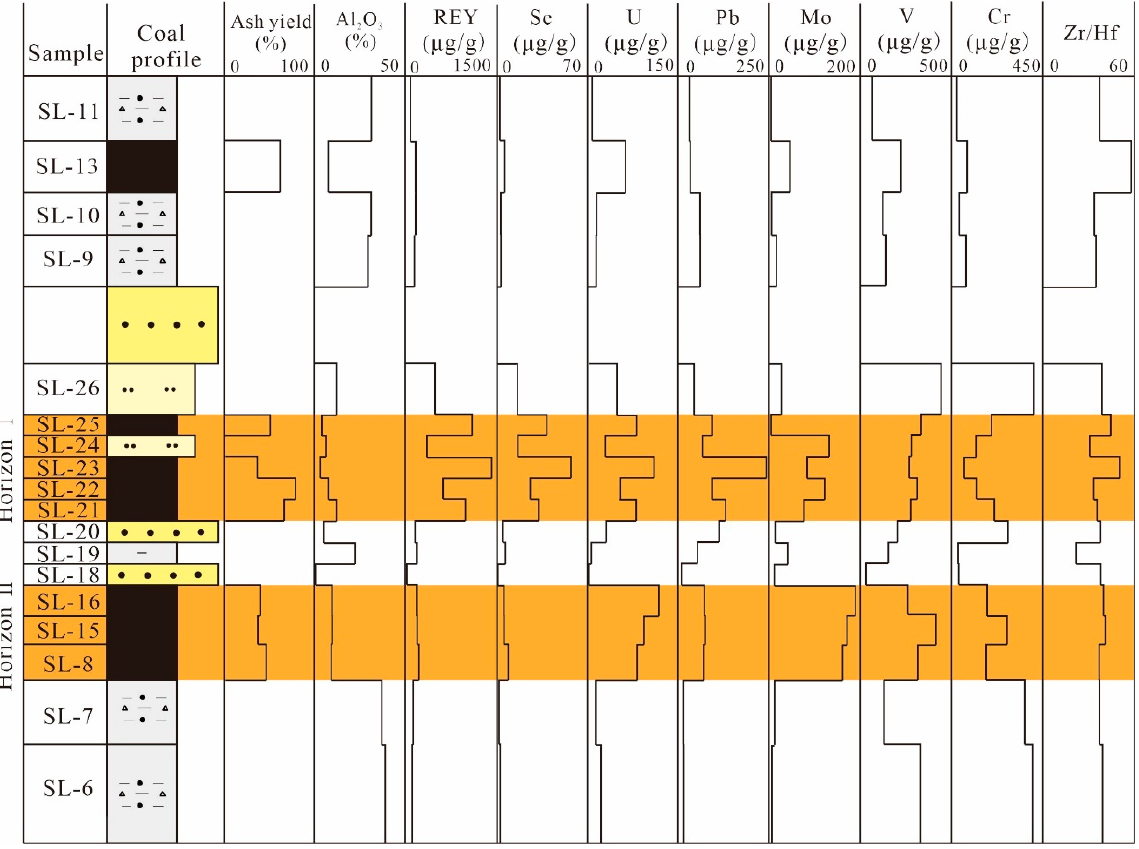
Figure 9. Vertical distribution of ash yield, selected elements, and element ratios throughout the outcrop profile.